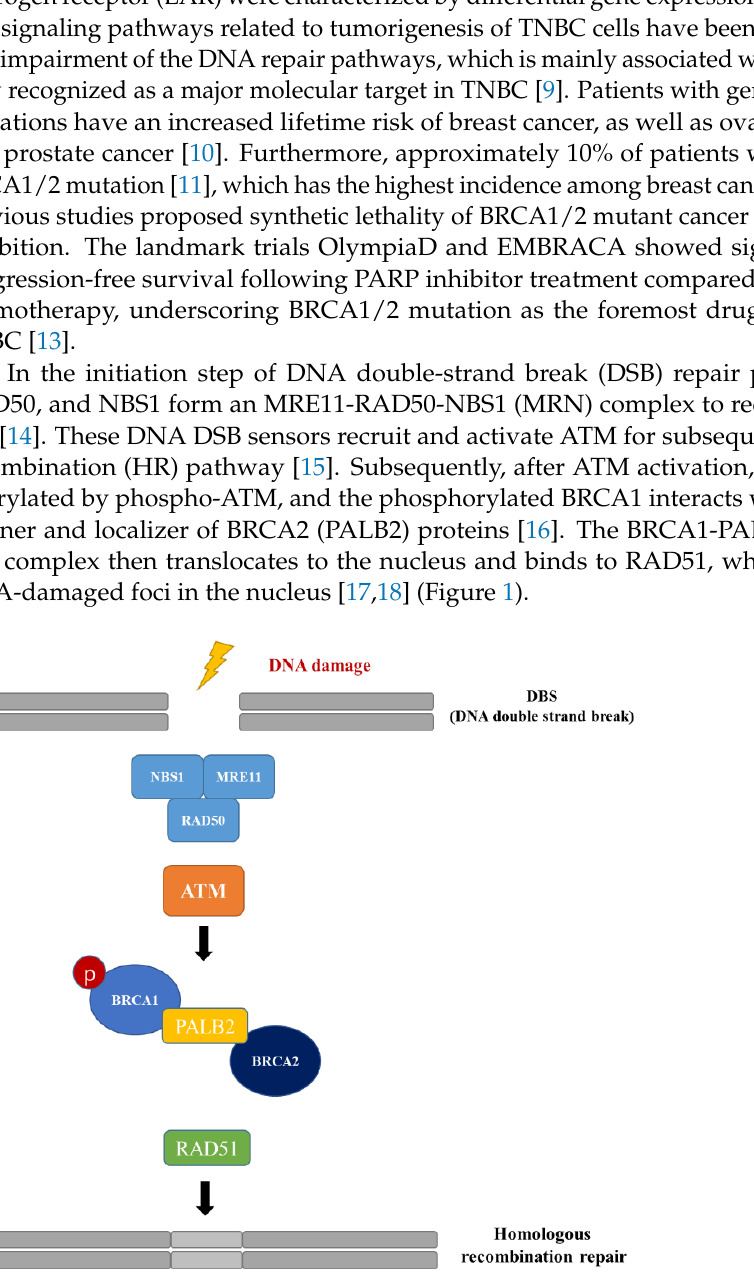
Figure 1. HR pathway activated by DSBs. After DSB occurs, ATM is recruited by the MRN complex (MRE11, RAD51, and NBS1) at the DSB site, and phosphorylated. A complex of BRCA1-PALB2-BRCA2 translocate to the cell nucleus and binds to RAD51. The RING and BRCA1 C-terminal (BRCT) domains in BRCA1 play a major role in the HR pathway [19]. BRCT domains act as phosphopeptide-binding modules following